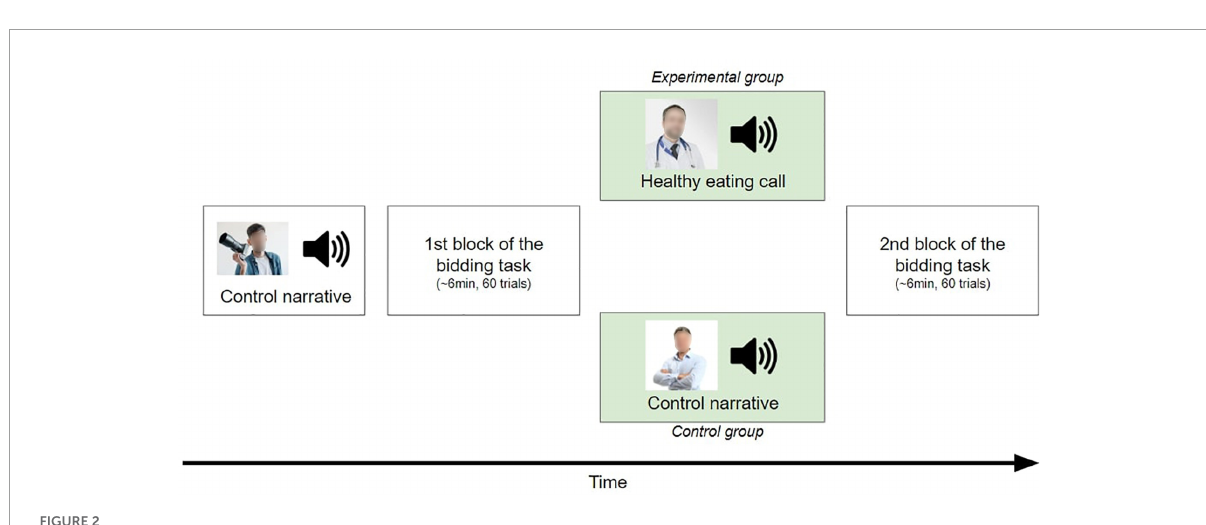
FIGURE2 Schematic representation of the experimental